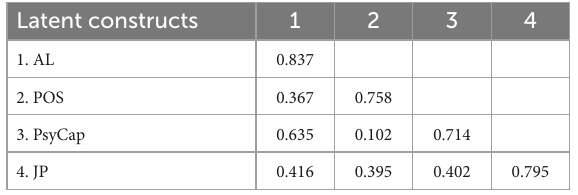
TABLE 2 Discriminant validity test results.